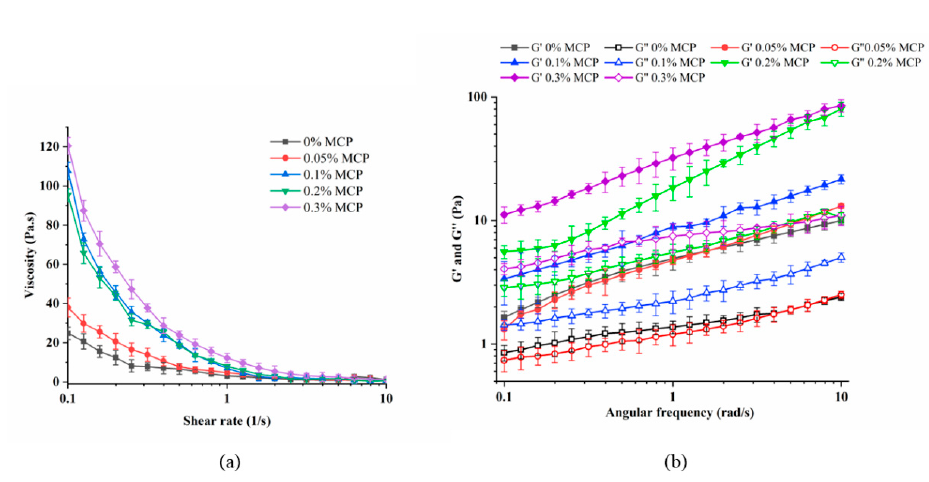
Figure 4. Apparent viscosity ( a ) and dynamic rheological properties ( b ) of WPI, WPI-MCP emulsions. Error bars are ± SD of the means.